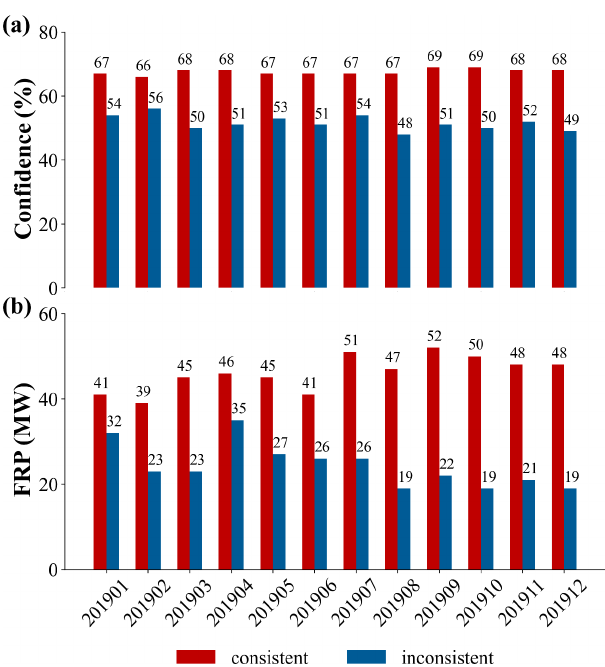
Figure 8. (a) Confidence of consistent and inconsistent pixels be- tween FY-3D and MODIS fire products. (b) FRP of consistent and inconsistent pixels between FY-3D and MODIS fire